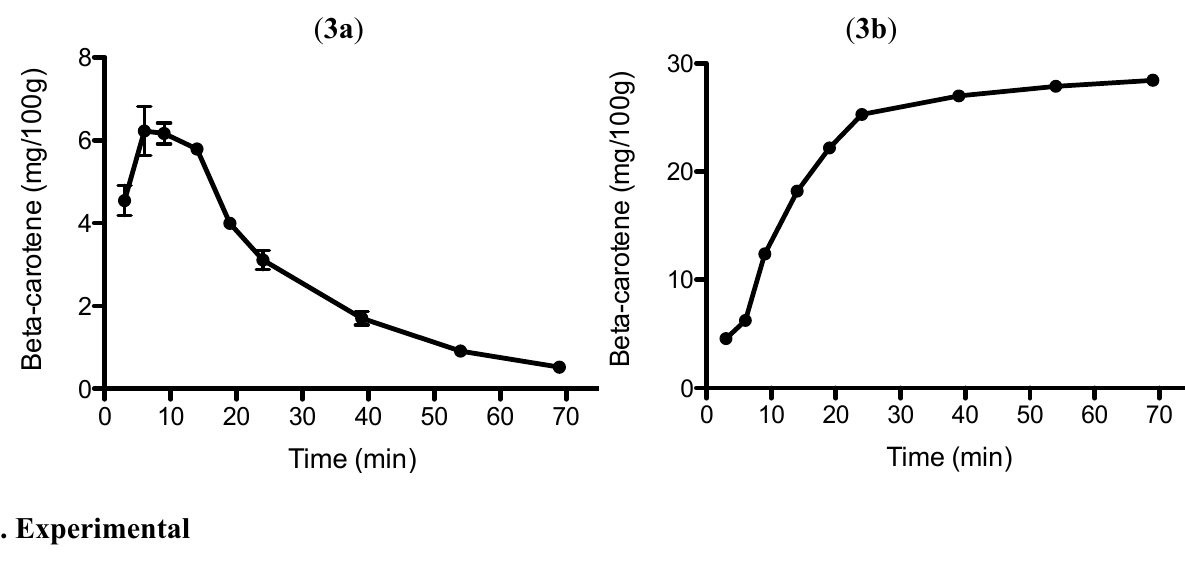
Figure 3. Extraction yield of β -carotenes from fresh carrots as a function of extraction time; ( A ) yield after each cycle (3 × 2 min plus 3 × 5 min plus 3 × 15 min); ( B ) extraction curve showing cumulative concentrations. Bars shows variation in replicates, n = 3. Samples were extracted at 60 